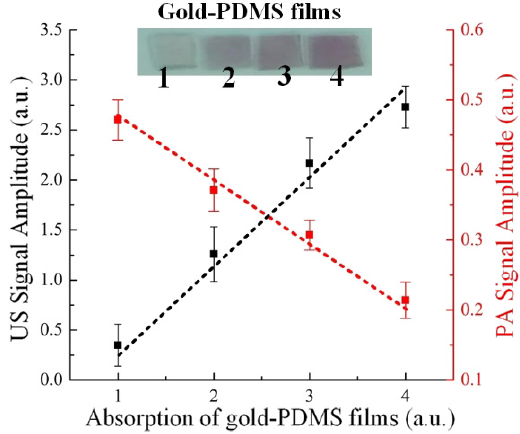
Fig. 8. The PA and US signal amplitudes as a function of the optical absorption of the gold-PDMS ¯lm. The thickness of the ¯lms are kept to be 80 (cid:1)